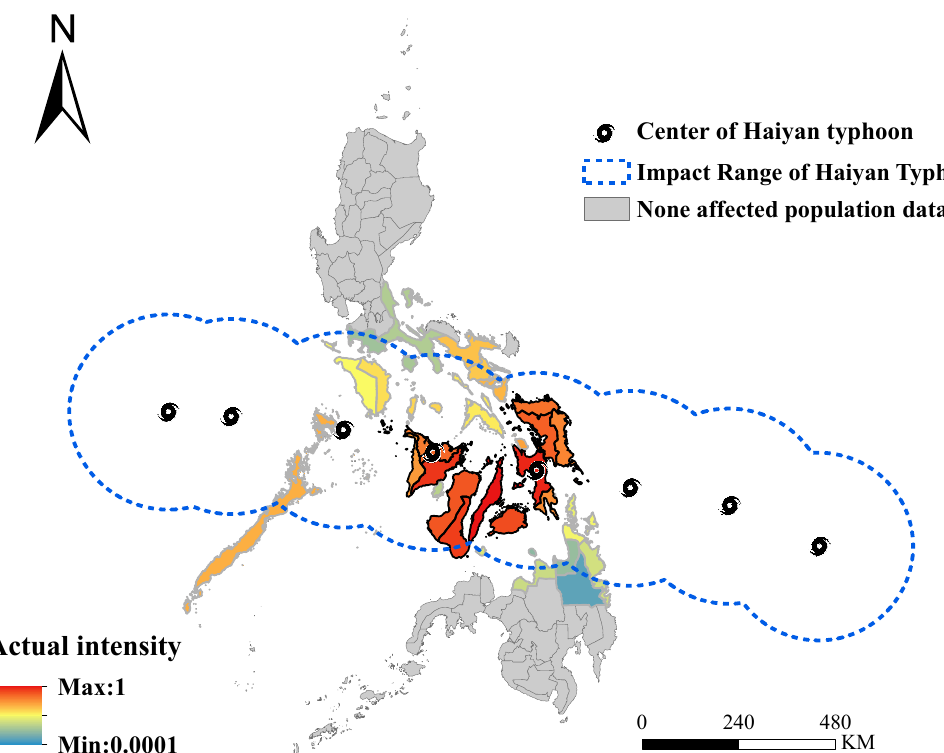
Figure 2. The actual affected population intensity by Typhoon Haiyan.